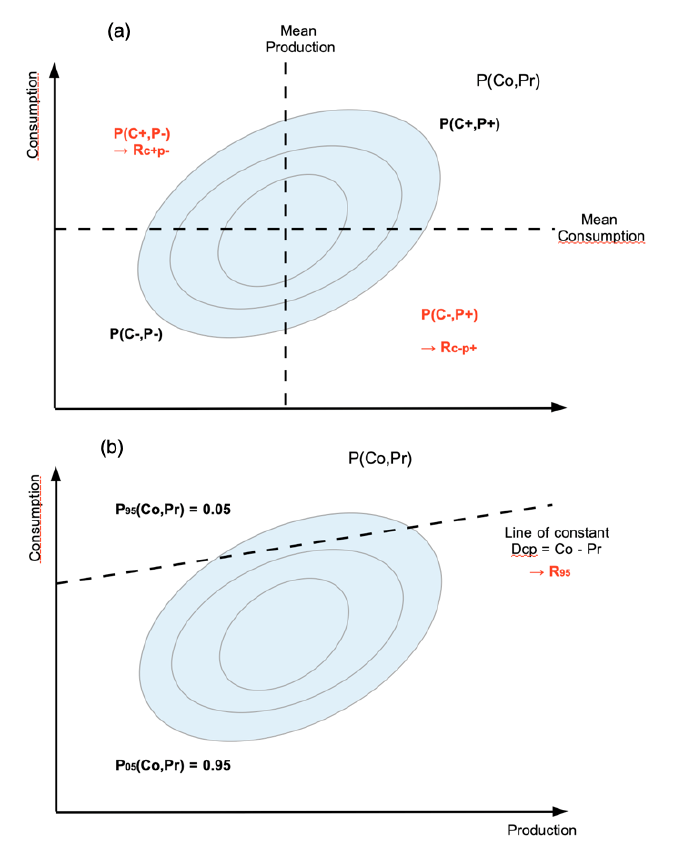
Figure 1. ( a ) Schematic of the joint distribution P ( Co , Pr ) for a given season overlaid with the climatological production and consumption averages ¯ Pr and ¯ Co displayed with the vertical and horizontal lines. The quantities C + , C − , P + and P − correspond to Co > ¯ Co , Co < ¯ Co , Pr > ¯ Pr and Pr < ¯ Pr , respectively. The quantities R c + p − = P ( Pr < ¯ Pr , Co > ¯ Co ) and R c − p + = P ( Pr > ¯ Pr , Co < ¯ Co ) correspond to risk of low production and high consumption and to risk of low consumption and high production, respectively. ( b ) Schematic of the joint distribution P ( Co , Pr ) for a given season overlaid with the line of constant Dcp = Co − Pr which separate the probability into a part where P ( Co , Pr ) = 0.05 and another where P ( Co , Pr ) = 0.95. The corresponding quantity Dcp = R 95 is the Value at Risk 95 ( VaR 95 ) of